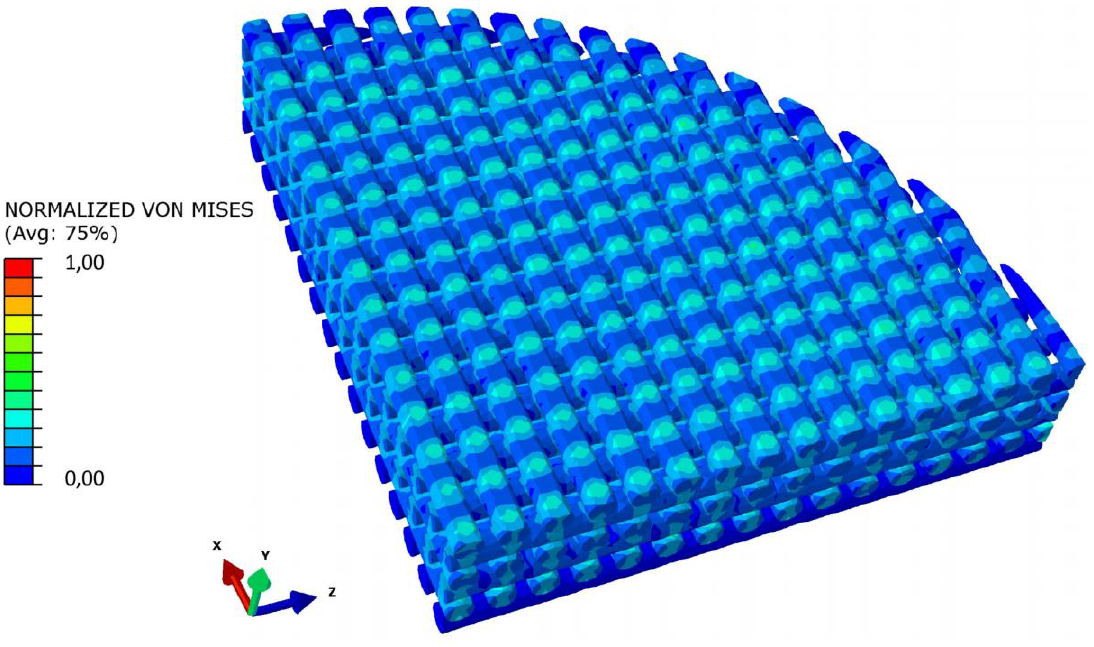
Figure 11. Normalized von Mises stress distribution in a section of the scaffold model. Stress peaks are in alignment with the filaments of the previous layer.